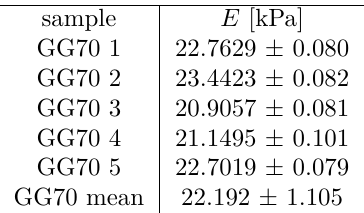
Figure 2. Stress–strain curves envelope of scaffolds under tensile